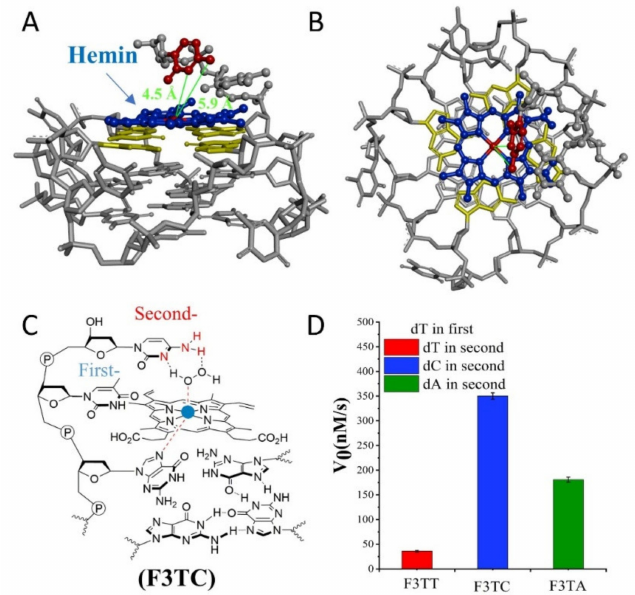
Figure 3. ( A , B ) Molecular model of F3TC. A: side view, B: top view. ( C ) Schematic representation of hemin intermediate with F3TC. The 3 (cid:48) flanking dC makes the 4-NH 2 and N3 group concertedly form two hydrogen bonds (N3-H-O α and 4-NH-H-O β ) with H 2 O 2 . ( D ) Summary of the catalytic activity of